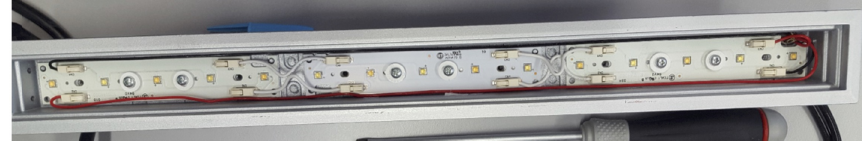
Figure 4. The Laser Blade is based on 7 cool Correlated Color Temperature (CCT) LEDs and 8 warm CCT LEDs positioned alternately with each other.